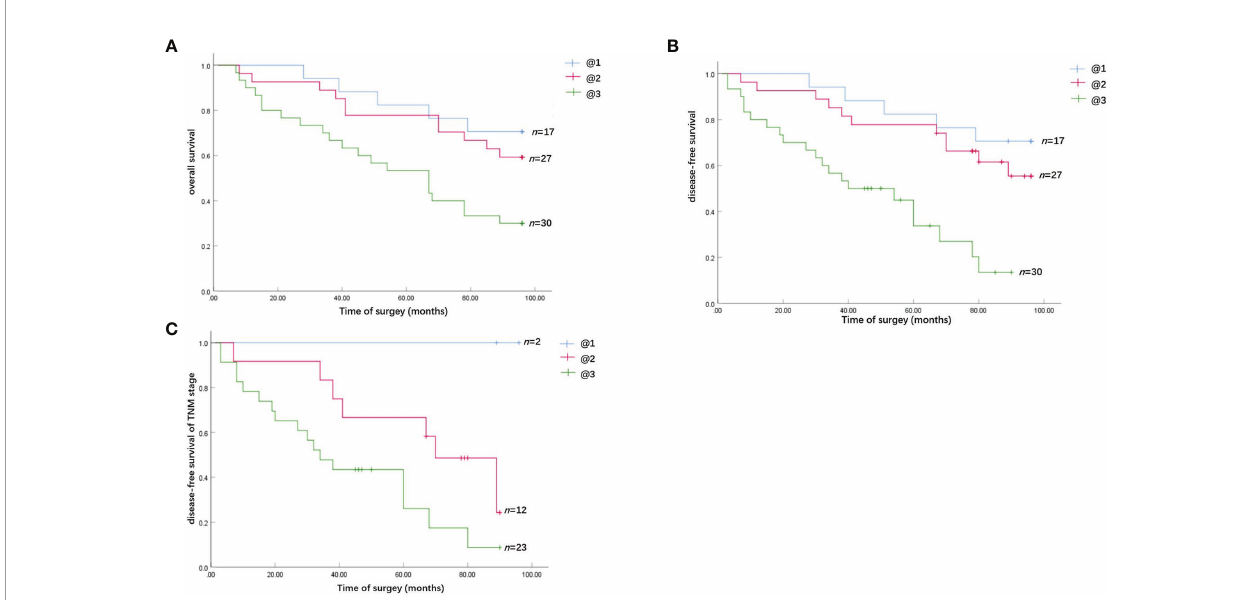
FIGURE 2 | Survival analysis of the effect of Chemerin expression and TANs in fi ltration on OSCC patients. (A) The overall cancer-related survival of OSCC patients in the strong Chemerin expression + high TANs density group was signi fi cantly reduced, compared with the weak Chemerin expression + low TANs density group ( P = 0.008, log-rank test) and strong Chemerin expression + low TANs density group/weak Chemerin expression + high TANs density group ( P = 0.017, log-rank test). (B) The OSCC patients in the strong Chemerin expression + high TANs density group also had signi fi cantly reduced disease-free survival related to cancer, compared with the weak Chemerin expression + low TANs density group ( P = 0.000, log-rank test) and strong Chemerin expression + low TANs density group/ weak Chemerin expression + high TANs density group ( P = 0.001, log-rank test). (C) In TNM stage III and IV OSCC patients, the cancer-related disease-free survival of OSCC patients in the strong Chemerin expression + high TANs density group was signi fi cantly reduced ( P = 0.045, log-rank